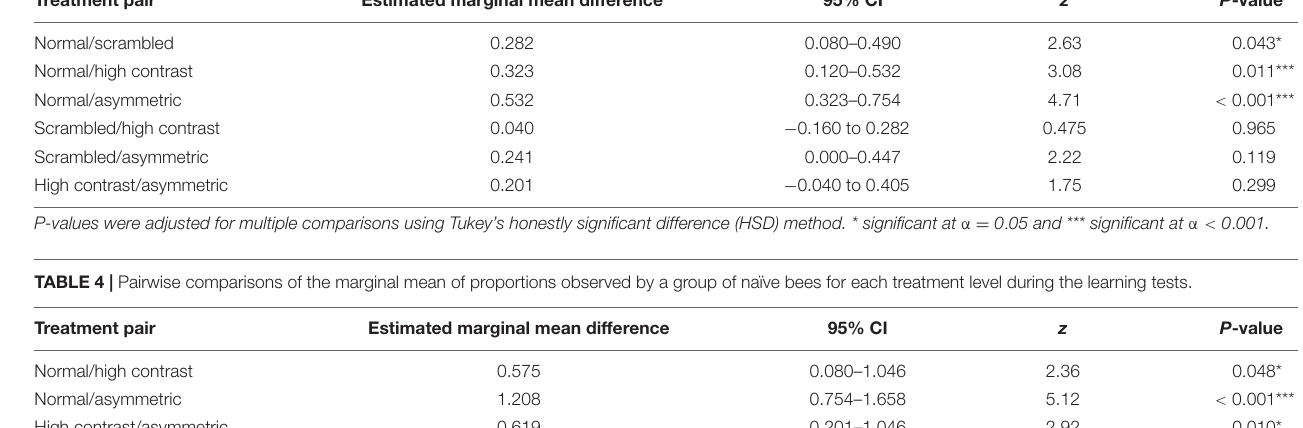
FIGURE 6 | Mean number of correct choices for images representing normal (NF), scrambled (SF), high contrast (HCF), and asymmetric scrambled (ASF) images of flowers by experienced (A) and naïve bees (B) observed during the learning tests. Error bars represent the 95% confidence intervals for the mean in all cases. Asterisks indicate a mean number of correct choices significantly different from chance level expectation of 50% (grey line) at *P < 0.05, ** P < 0.001, and *** P < 0.001. NS indicates a mean proportion of choices not significantly different from chance. TABLE 3 | Pairwise comparisons of the marginal mean of proportions observed by a group of experienced bees for each treatment level during the learning tests. Treatment pair Estimated marginal mean difference